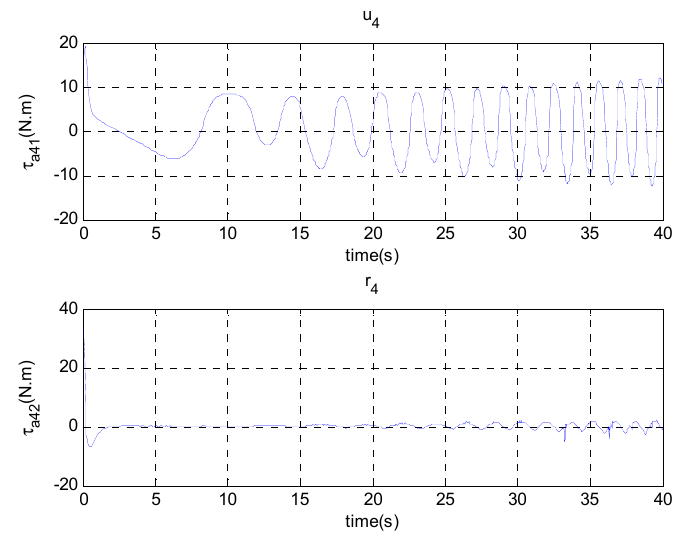
Figure 15. Applied input control of the fourth follower in Example 2.